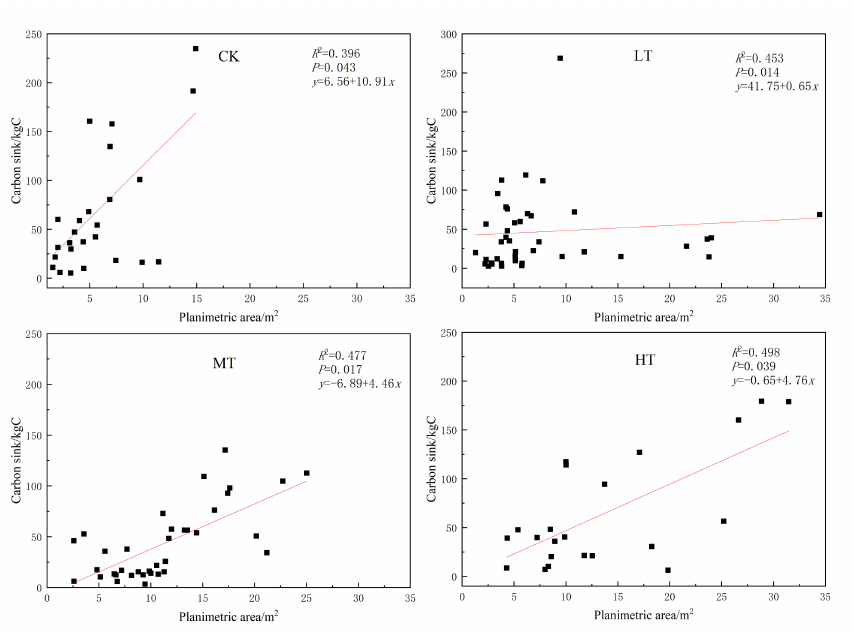
Figure 5. Relationship between crown area and carbon stock under different